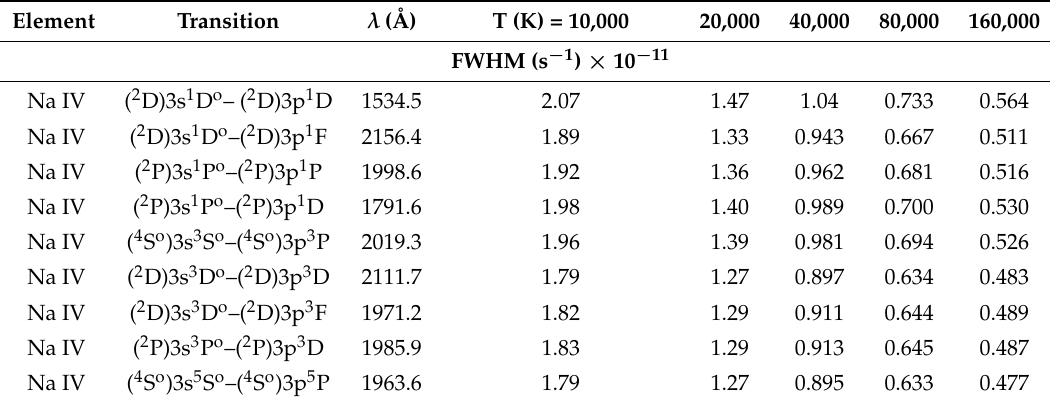
Table 2. Same as in Table 1, but FWHM is in angular frequency